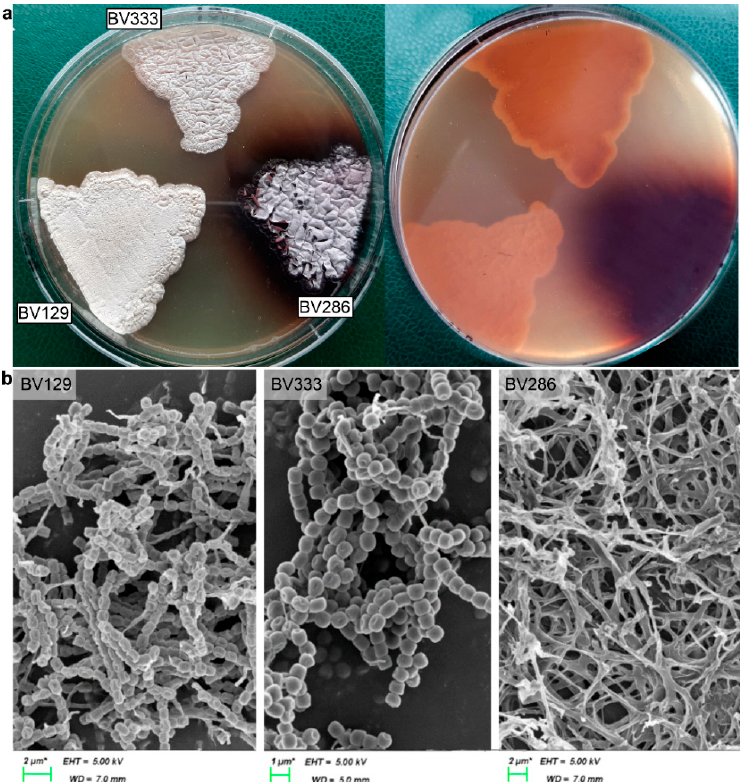
Figure 1. Streptomyces sp. BV129, BV333 and BV286 morphology upon growth for 7 days on mannitol–